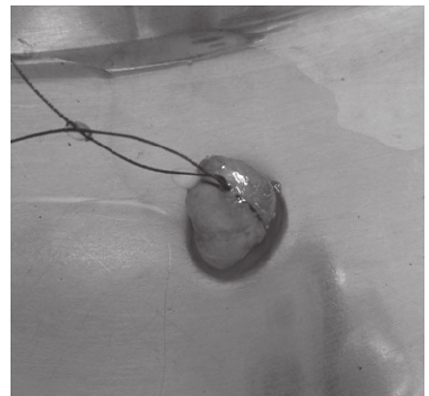
Figure 2. Picture showing excised mass